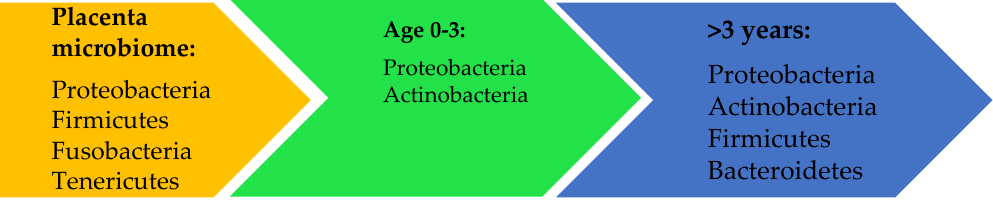
Figure 1. The most prevalent bacterial phyla in utero and in the GI-tract of humans. This figure represents the dynamic and development of the composition of the microbiome from fetuses in utero until the age of three years, at which point the microbiome gains its stability and consists of mostly four phyla: Proteobacteria, Actinobacteria, Firmicutes, and Bacteroides.